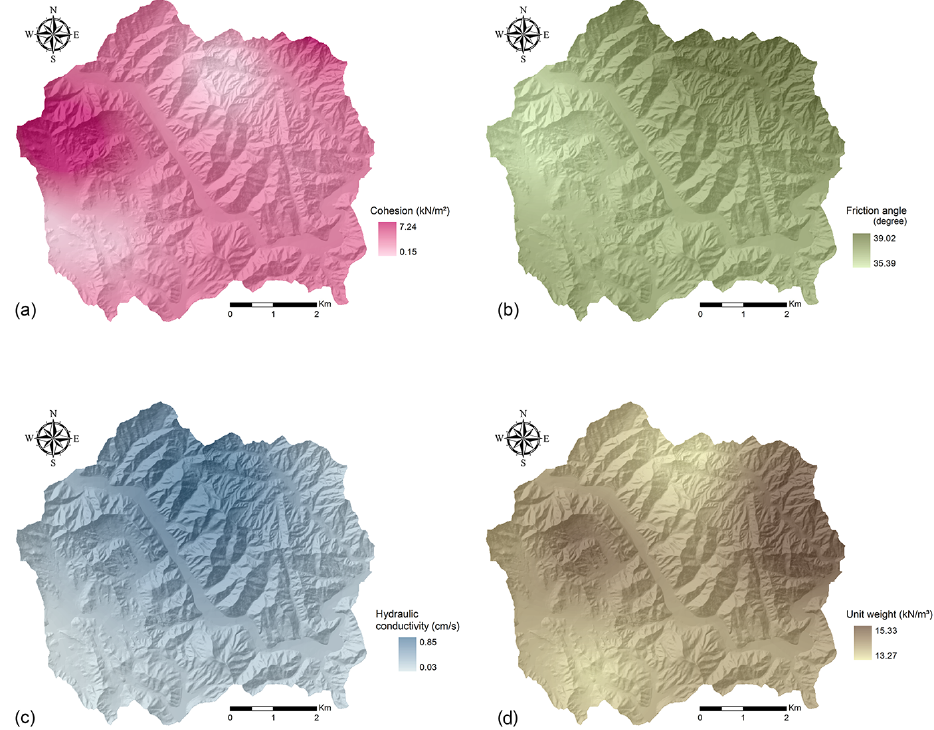
Figure 11. Map showing the distribution of geotechnical soil parameters. (a) Cohesion, (b) friction angle, (c) hydraulic conductivity and (d) unit weight.